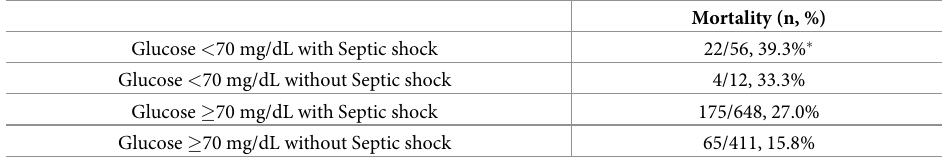
Table 4. In-hospital mortality in patients with or without hypoglycemia ( < 70 mg/dL) and septic shock.